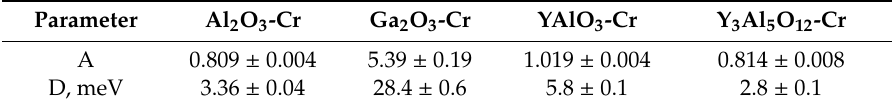
Table 2. Parameters of fits obtained from the temperature dependence of the luminescence intensity ratio, Equation (1), for Cr-doped oxides investigated in this